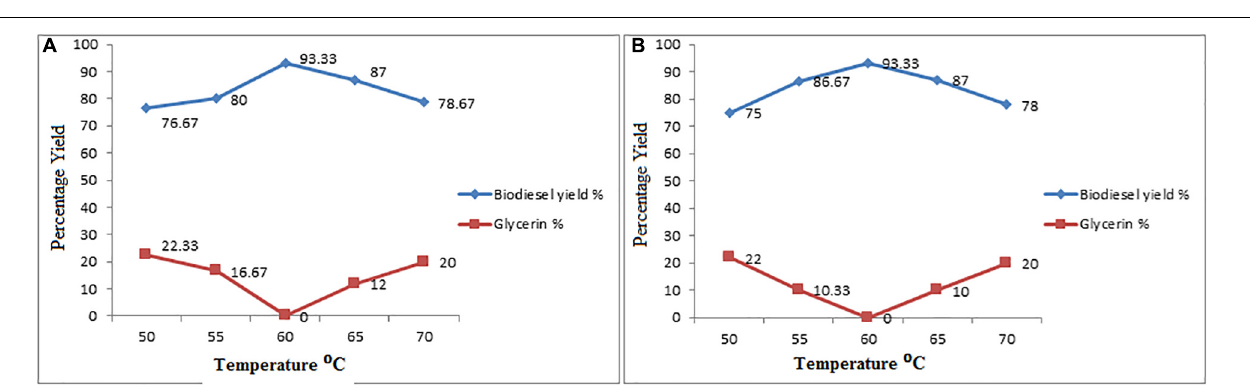
FIGURE 7 | (A,B) Effect of Reaction Temperature on Esterification and Transesterification